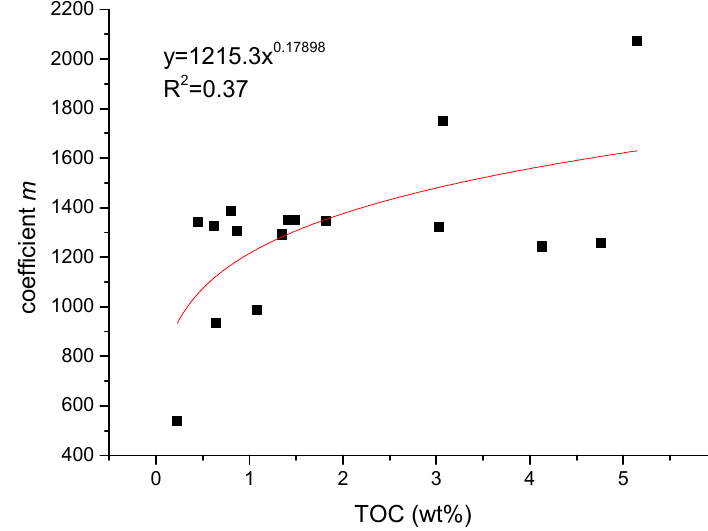
Figure 8. The relationship of the TOC to the fitting coefficient m.